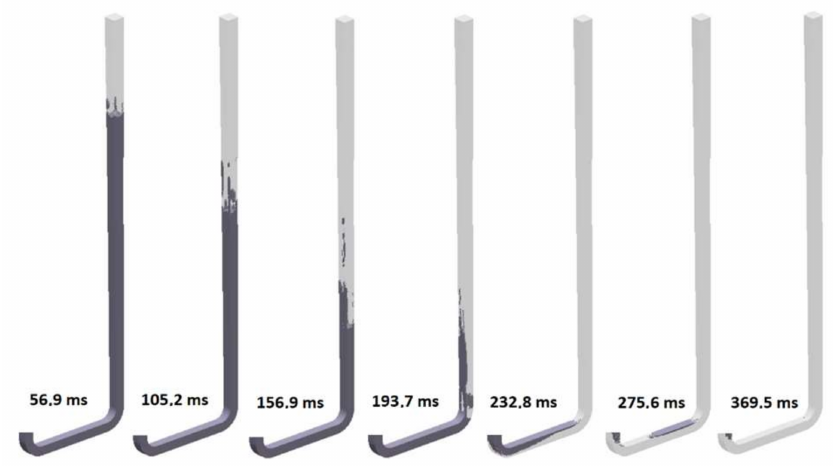
Figure 30. Air evacuation in square sprue with hyperbolic taper (S s 7),